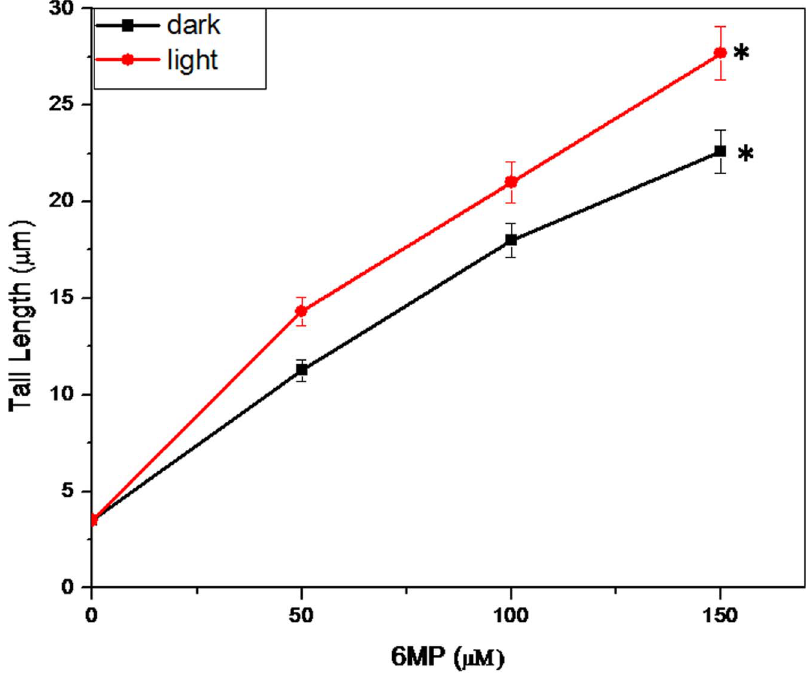
Figure 12. 6MP induced human lymphocyte DNA breakage. Comet tail length obtained after treatment with 6MP in dark and light. Values reported are 6 SEM of three independent experiments. * p value , 0.01 when compared to control.